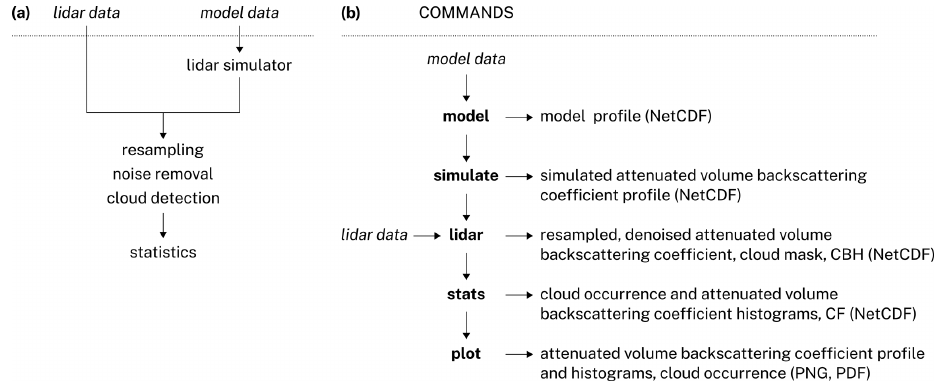
Figure 1. (a) Scheme showing the operation of the ALCF and (b) the processing